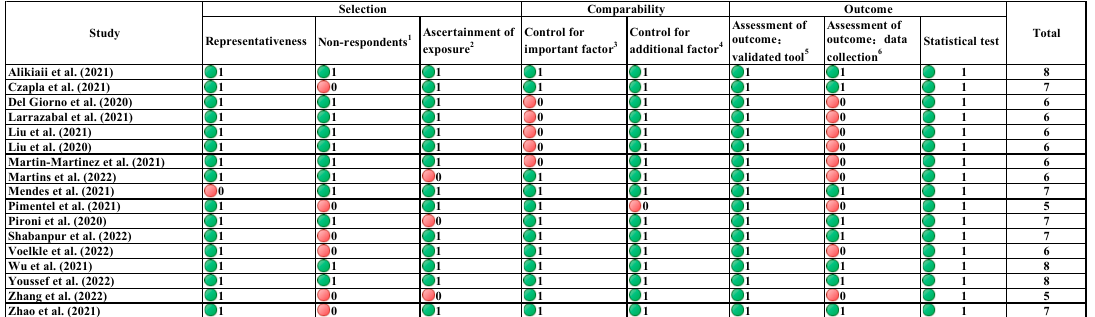
Figure 2. Quality assessment by Newcastle–Ottawa Scales (Green indicates score, red indicates no score) [36–52]. 1 Non-respondents: one point is granted if the individual study included data from all patients during the study period, or if they specified the number/proportion of patients excluded from the analysis. 2 Ascertainment of exposure: one point is granted if COVID-19 diagnosis/ascer- tainment method is clearly described in the individual study. 3 Control for important factor: In this meta-analysis, the primary stratification factor is the source of patients (ICU/general ward). One point is granted if the individual study specified the patient source, or when the study population